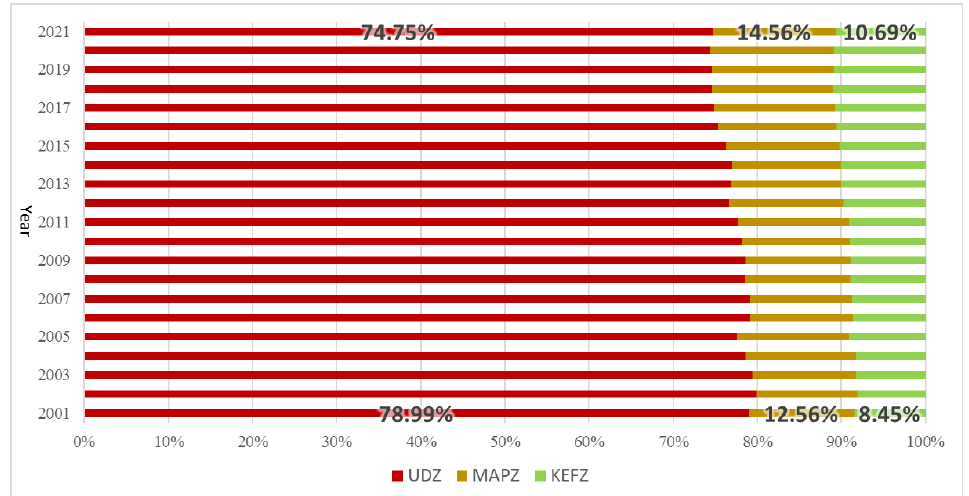
Figure 5. Changes in the proportion of carbon emitted from the three types of MFOZs in Guangdong Province from 2001 to 2021.